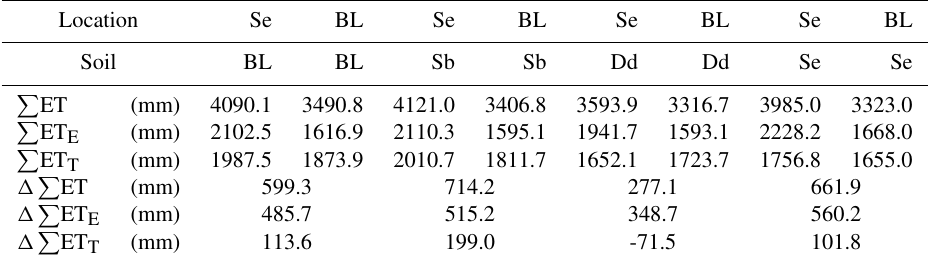
Table 1. Average values (of three lysimeters each) of cumulative evapotranspiration ( (cid:80) ET) for the whole observation period (2011–2017) and cumulative transpiration ( (cid:80) ET T ) and evaporation ( (cid:80) ET E ) for periods dominated by evaporation (E) or transpiration (T) for soils from Bad Lauchstädt (BL), Sauerbach (Sb), Dedelow (Dd) and Selhausen (Se) under a dry climate at BL and a wet climate at Se. The ET T values were defined from the beginning of the vegetation period (April) until ripening/maturity of the fruit or seeds; the data for (cid:80) ET E comprised the values from rest of the season. The differences of the cumulative values for the same soils between the sites BL and Se are denoted by (cid:49) (cid:80) ET, (cid:49) (cid:80) ET E and (cid:49) (cid:80) ET T